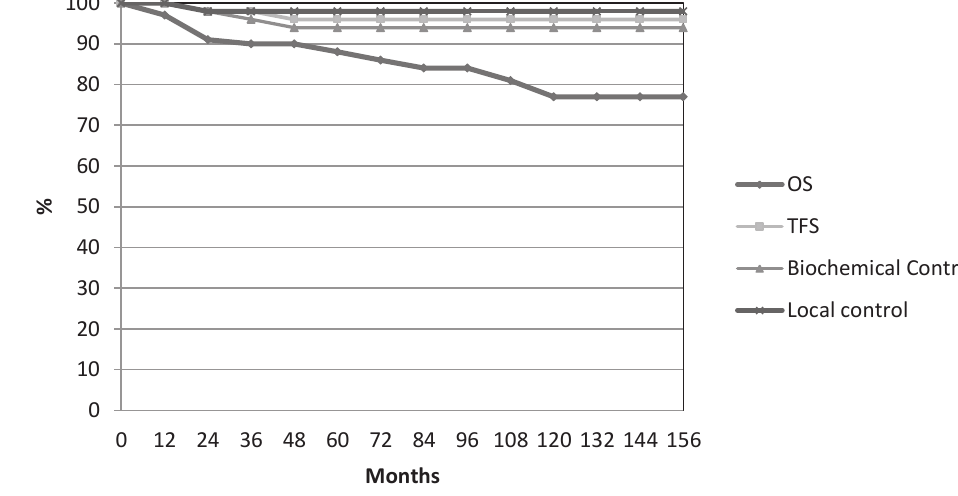
Figure 1. Actuarial analysis of all 57 patients for overall survival, tumor - free survival and biochemical control and local control.